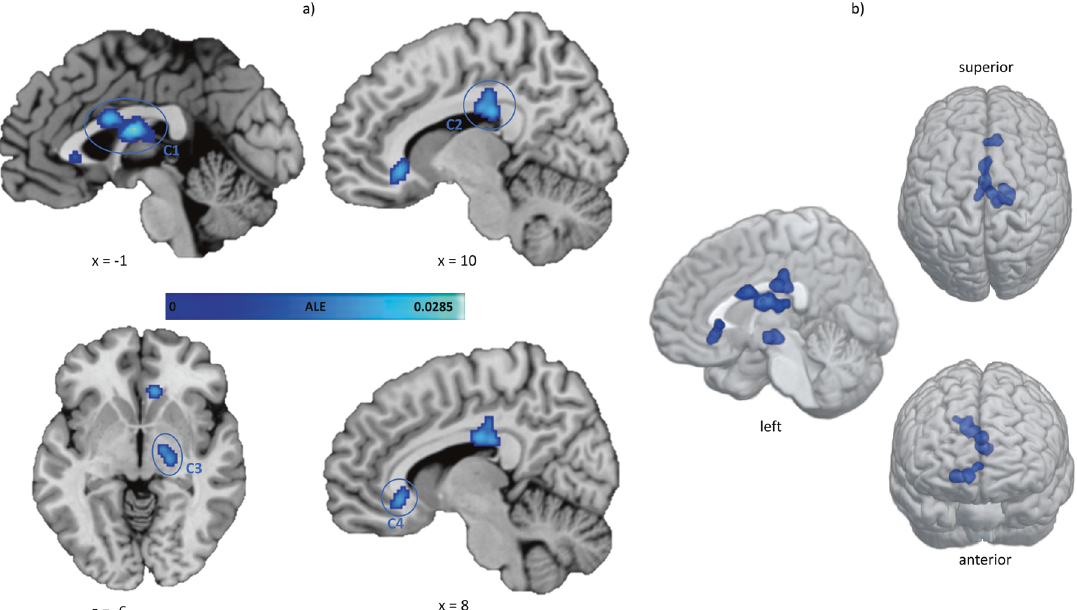
Fig. 2 Results of the ALE meta-analysis. The highlighted clusters (C1 – C4) represent signi fi cant convergence of white matter alterations in AUD patients compared to healthy controls. a Clusters are depicted on brain slices of an MNI standard brain. The color indicates the ALE value. b Spatial location and expansion of the ALE clusters depicted on a white matter glass brain. Cluster-forming threshold p < 0.001, FWE cluster level corrected at p < 0.05. x, y, and z values refer to coordinates in MNI space, for detailed MNI peak voxel coordinates of the ALE clusters see Table 2. This image was created with Mango (v4.1., http://ric.uthscsa.edu/mango/) and MRIcroGL (v1.2.20210317, https://www.